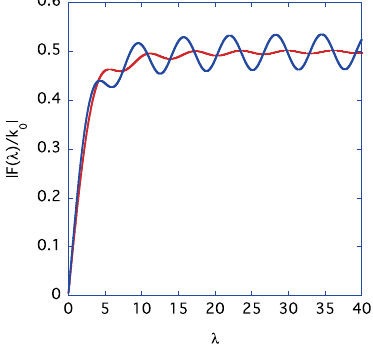
FIG. 2. The absolute value of the transfer function for the ð z Þ (red) and that for k coupling k new linnecar